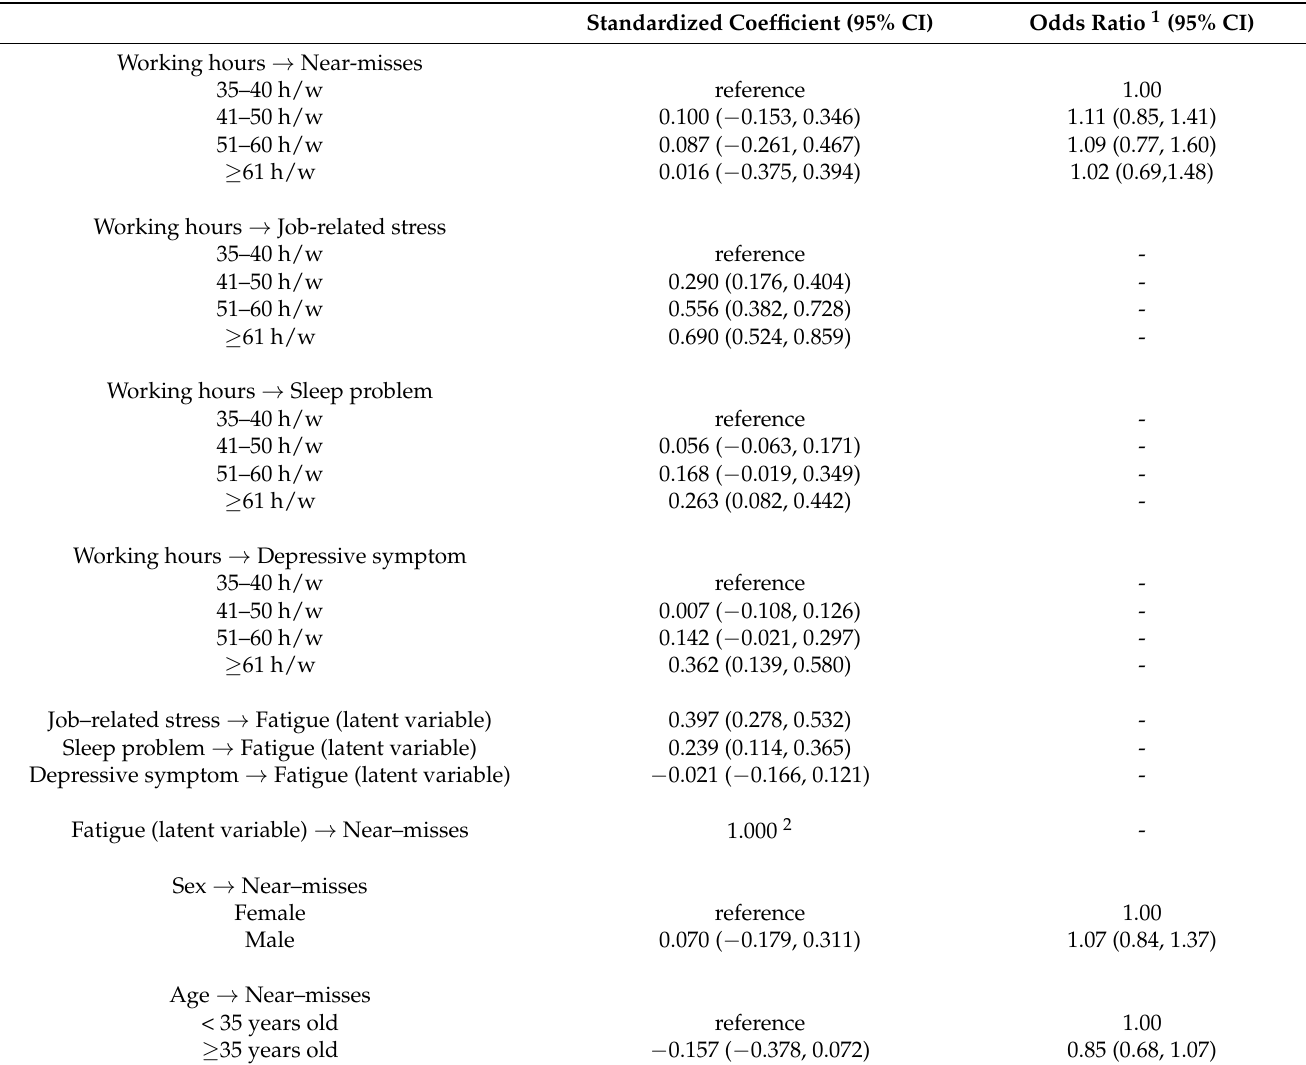
Table 2. Estimated standardized coefficients and odds ratios of generalized structural equation model for near-misses during the past six months among healthcare